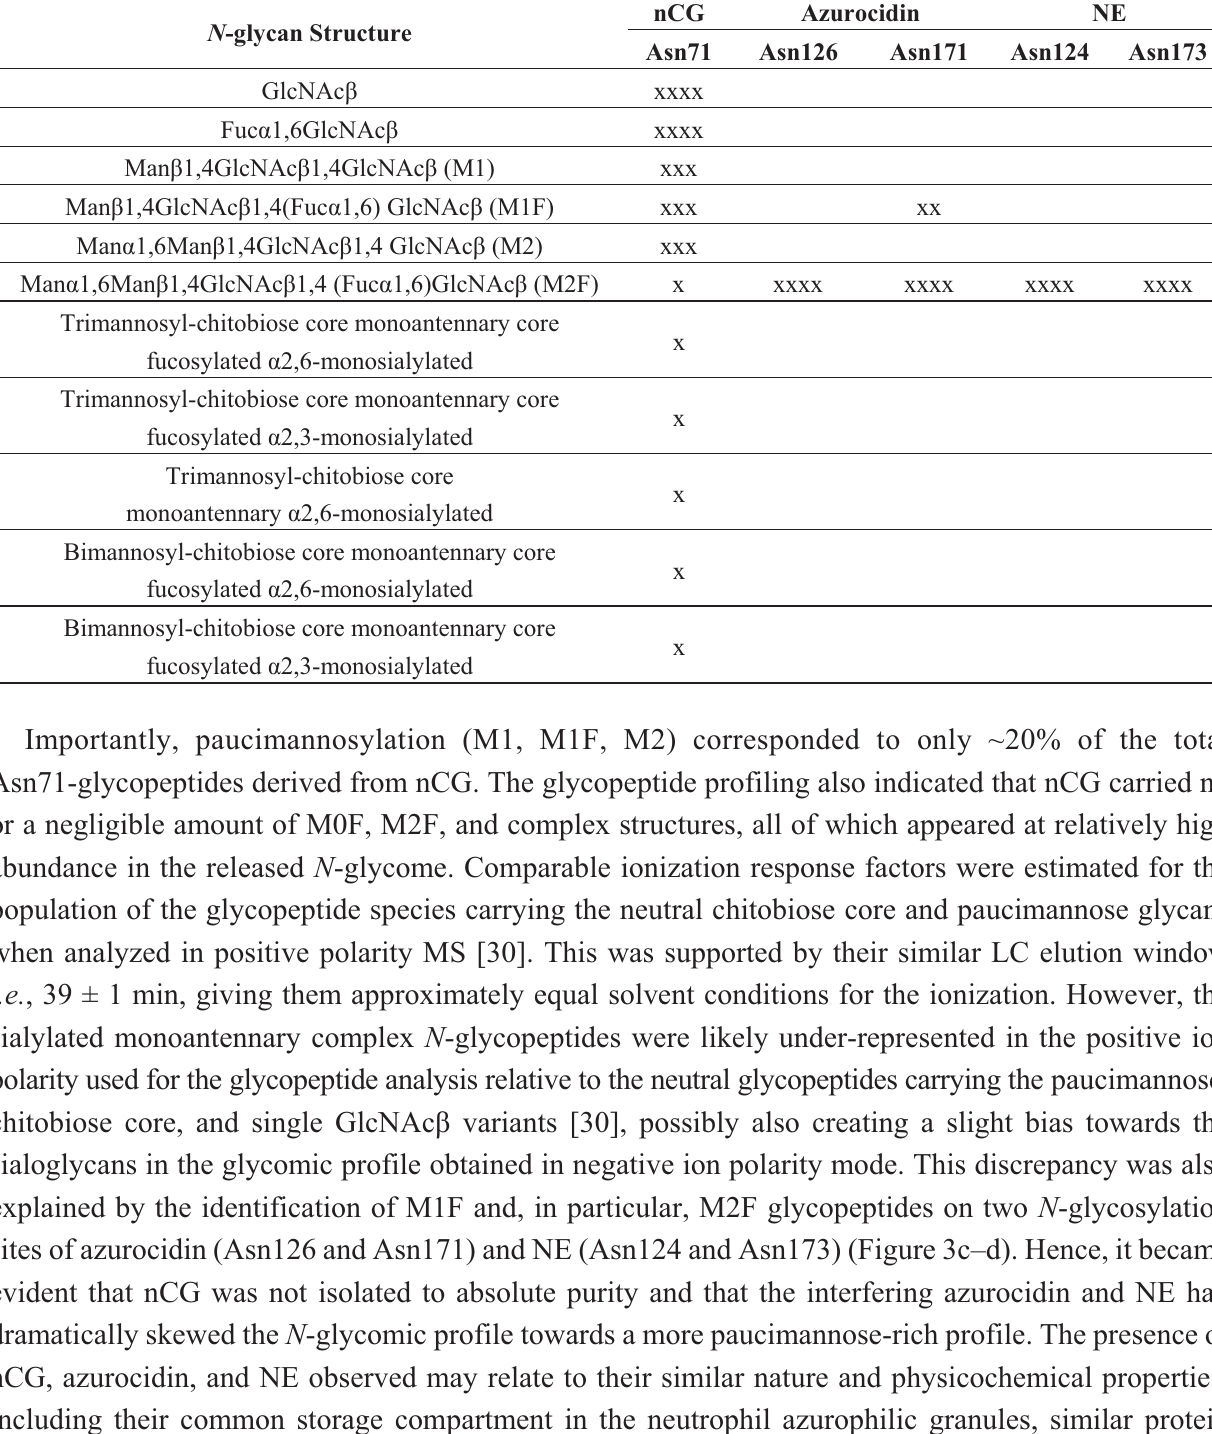
Table 1. Semi-quantitative overview of the site-specific N -glycosylation of human nCG, azurocidin and NE observed in this study. “xxxx” denotes glycoforms of high abundance, “xxx” glycoforms of intermediate abundance, “xx” glycoforms of low abundance and “x” trace (non-quantifiable) glycoform abundance. N -glycan Structure